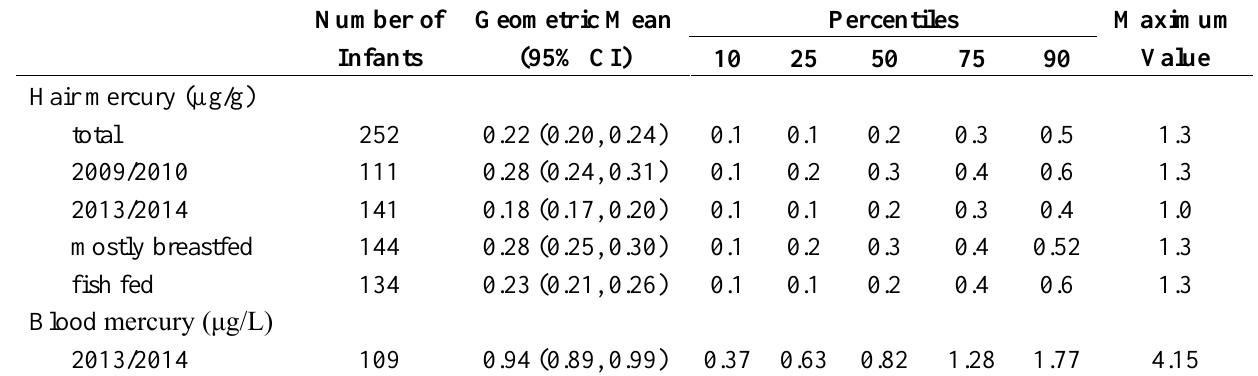
Table 2. Mercury content of hair and blood in